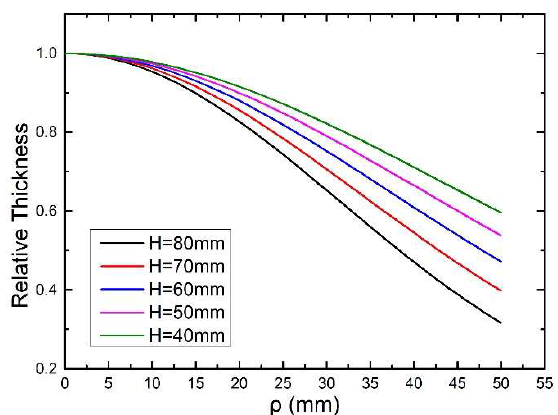
Figure 19. Relative film thickness distribution of H = 40, 50, 60, 70, 80 mm, ρ from 0 to 50 mm.